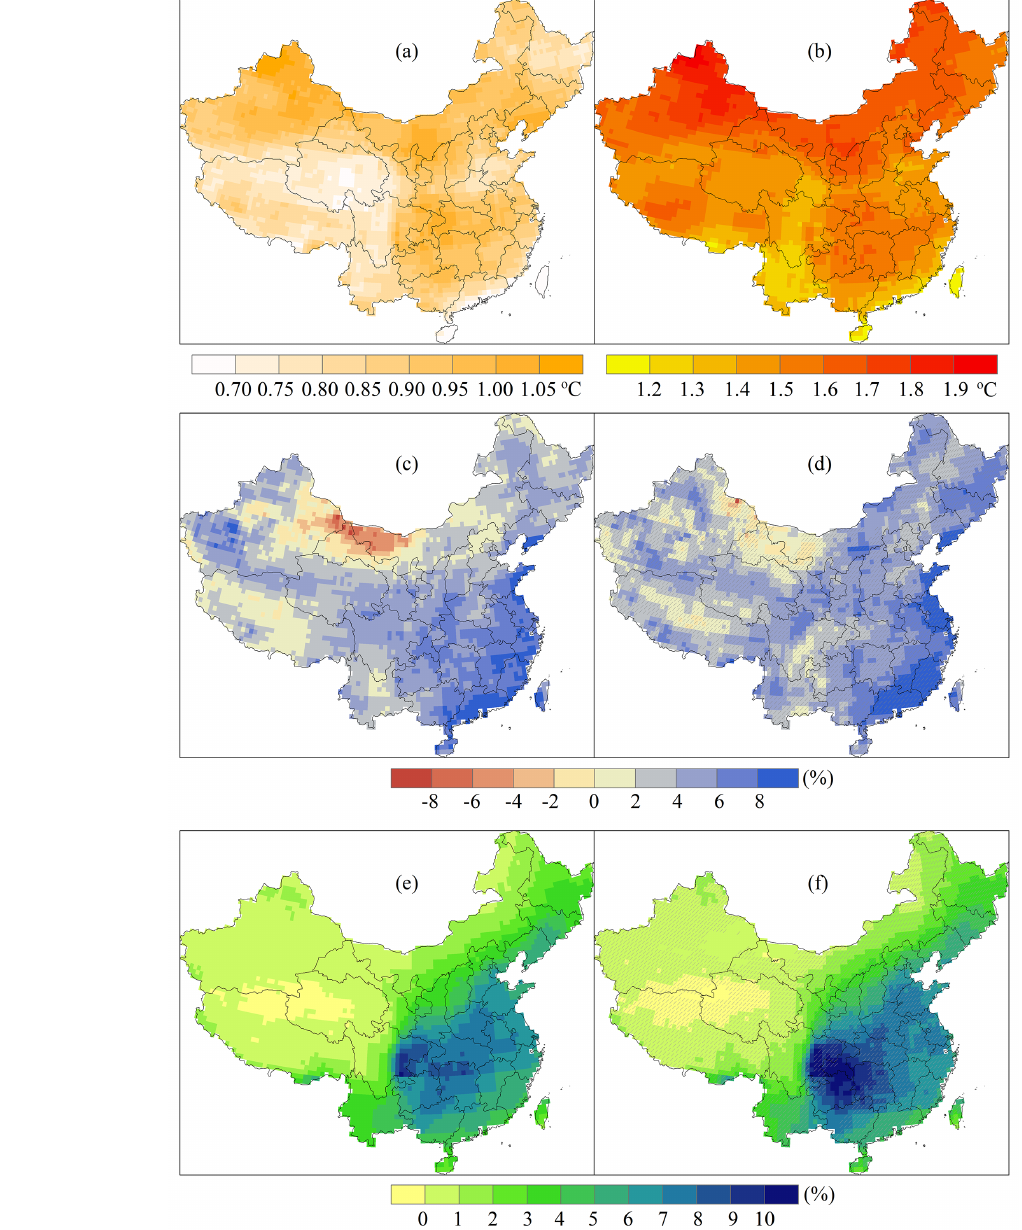
Figure 2. Median changes in mean temperature (a, b) , precipitation (c, d) and solar radiation (e, f) during 2106–2115 under the 1.5 ◦ C warming (a, c, e) and 2.0 ◦ C warming (b, d, f) scenarios relative to 2006–2015. Hatching indicates the areas where the differences between the 1.5 and 2.0 ◦ C warming scenarios are not significant ( P > 0 .